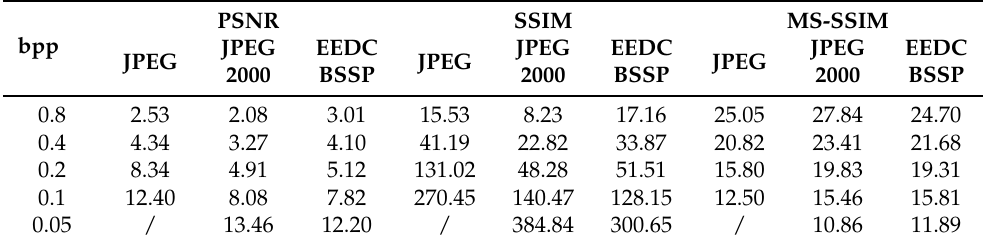
Table 15. Results of the AAE, MSE, and SNR metrics for image mask